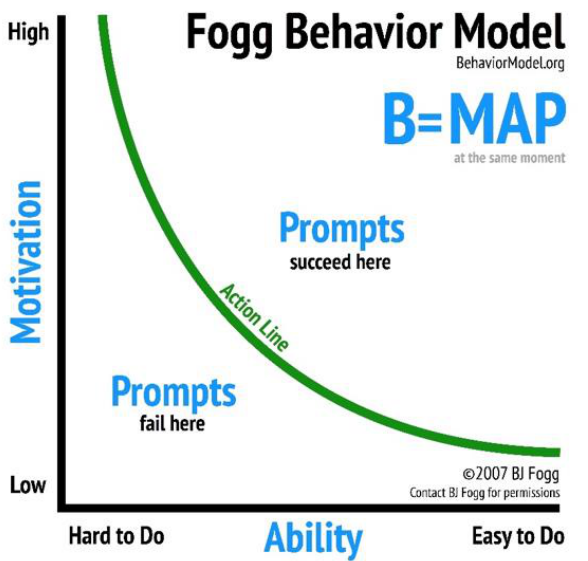
Figure 1. Fogg Behavior Model.